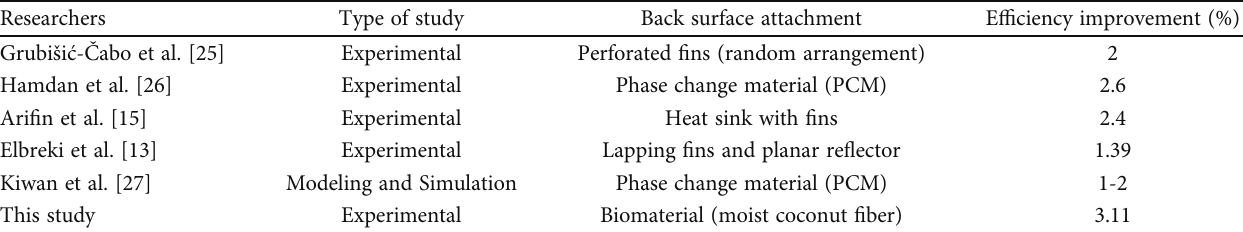
Table 4: Comparison of results with the other studies.